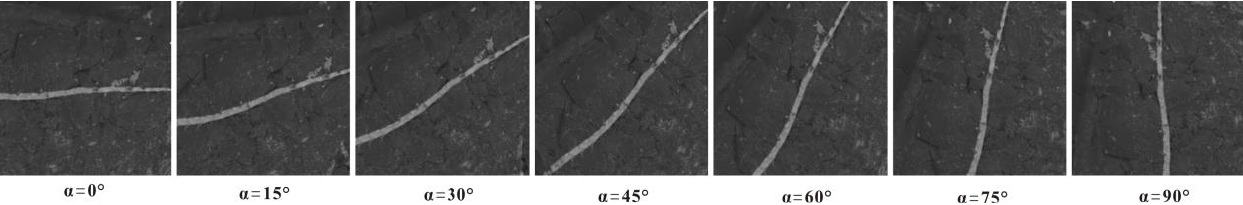
Figure 3. Digital images of coal and rock at different azimuth angles.